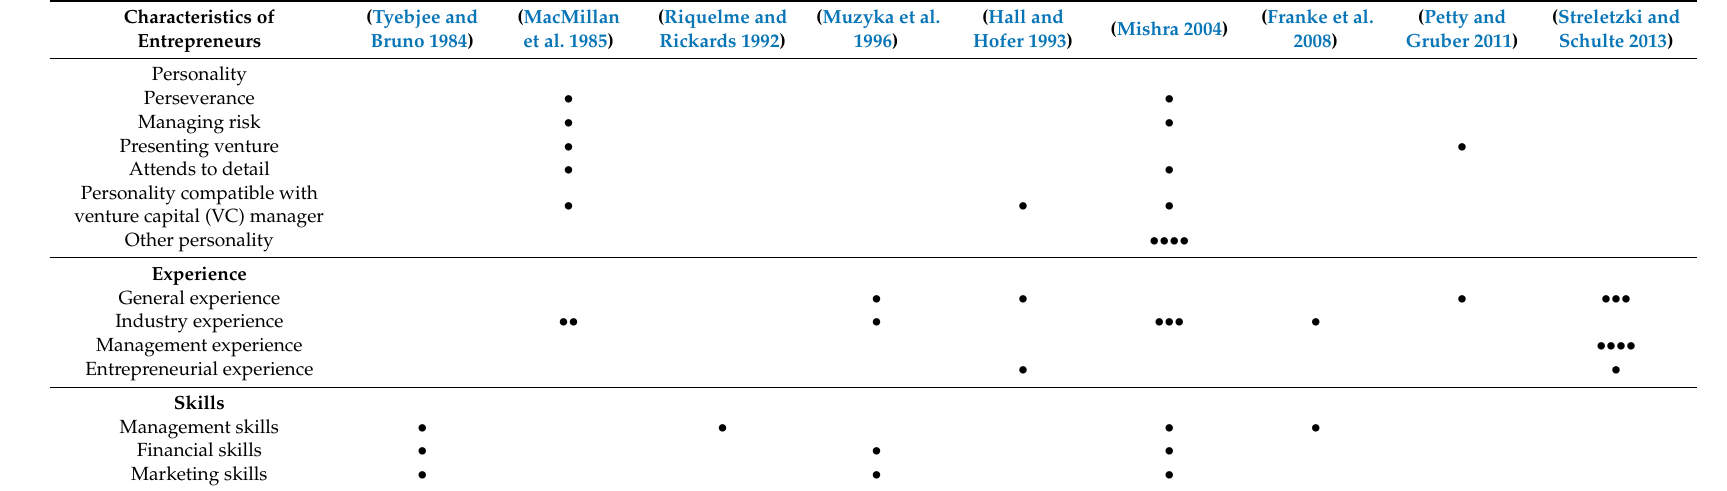
Table 2. Characteristics of entrepreneurs and management as VCs’ decision criteria in selected international